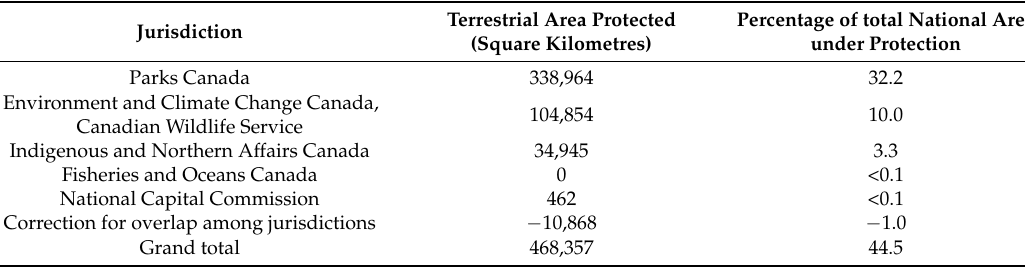
Table 2. Area protected by federal agency, Canada,